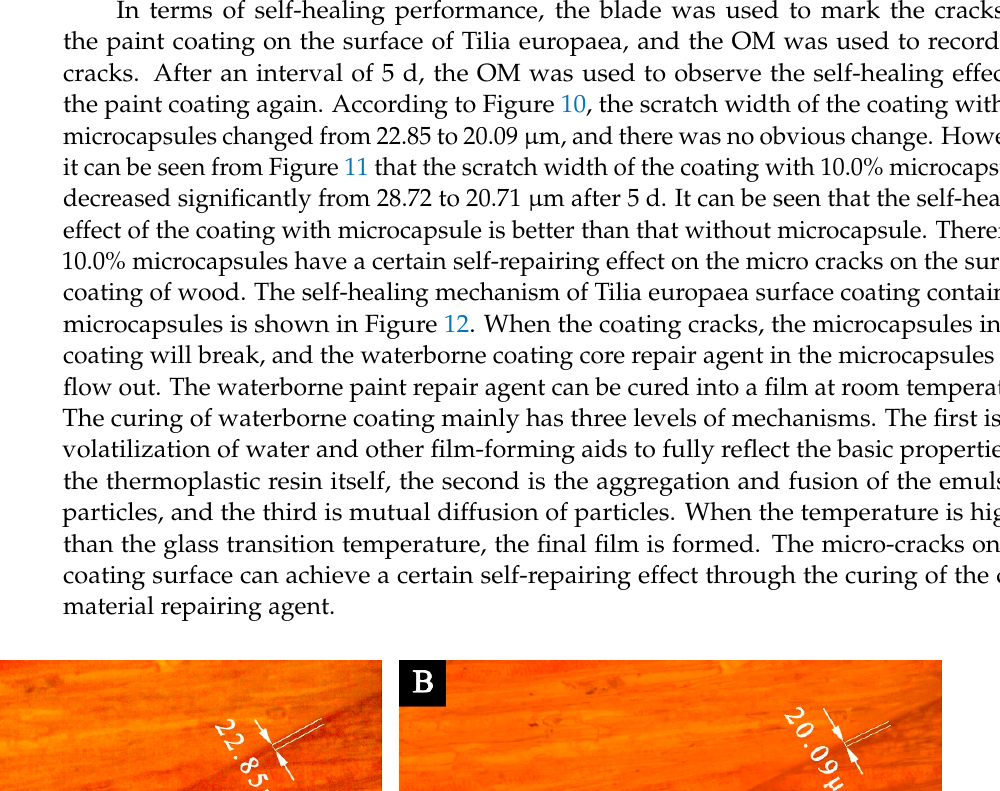
Table 10. Performance comparison of waterborne coatings with different microcapsules.